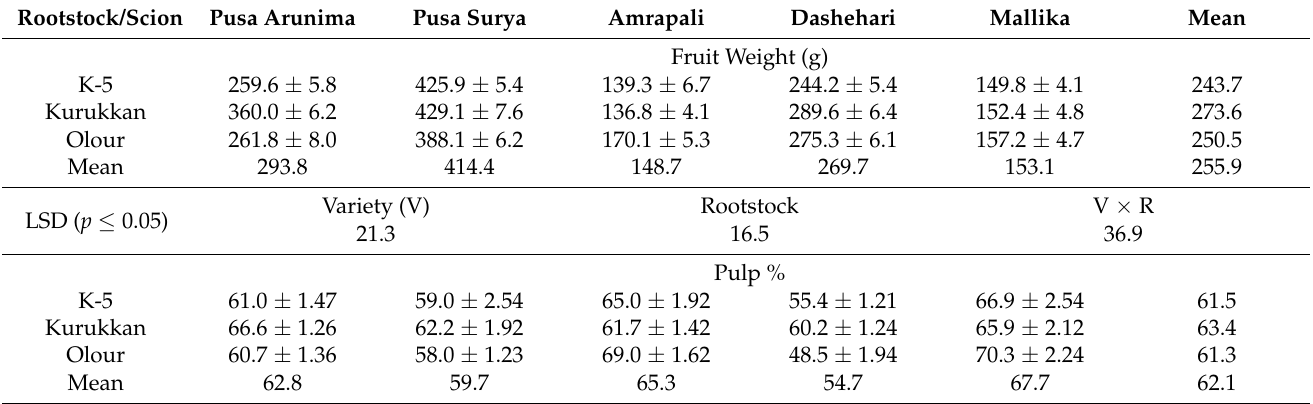
Table 2. Influence of rootstock, scion, and their interaction on fruit weight, pulp recovery, stone weight, and pulp/stone ratio in